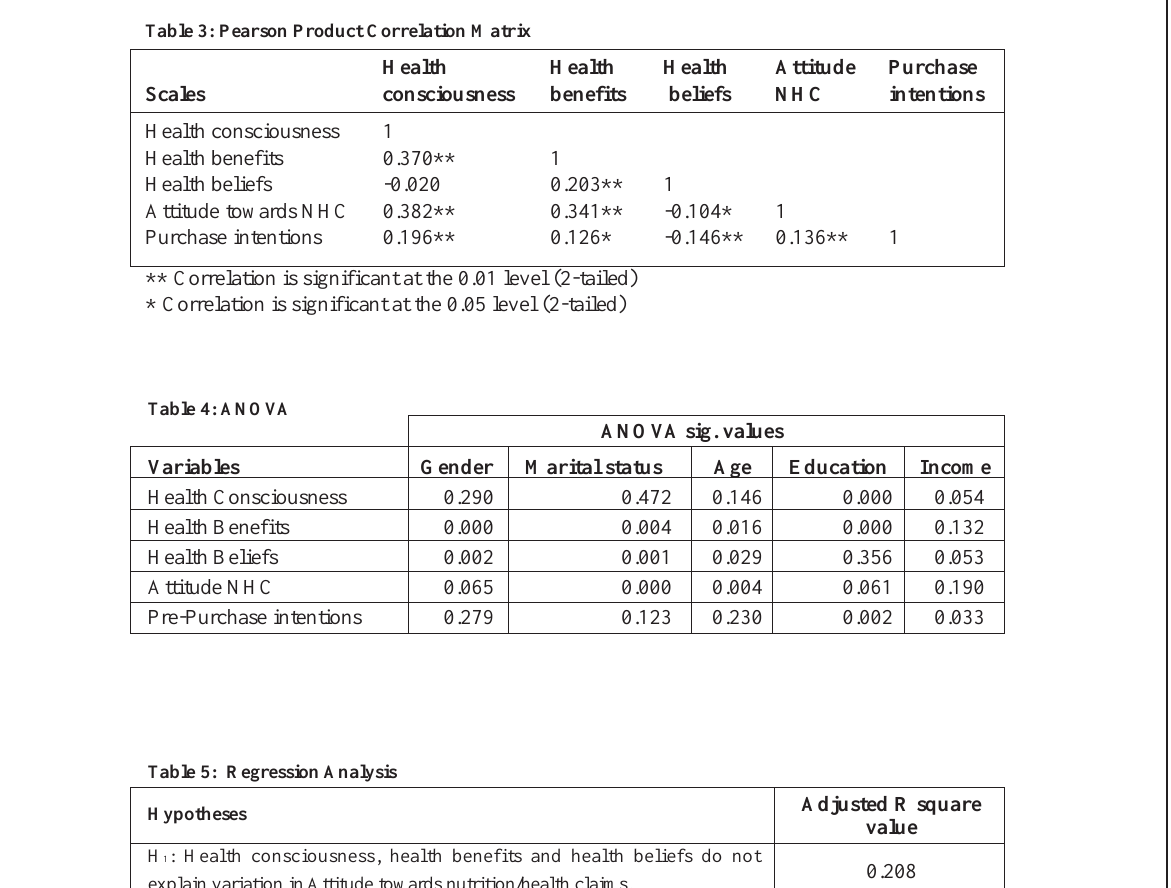
Table 3: Pearson Product Correlation Matrix Health Health